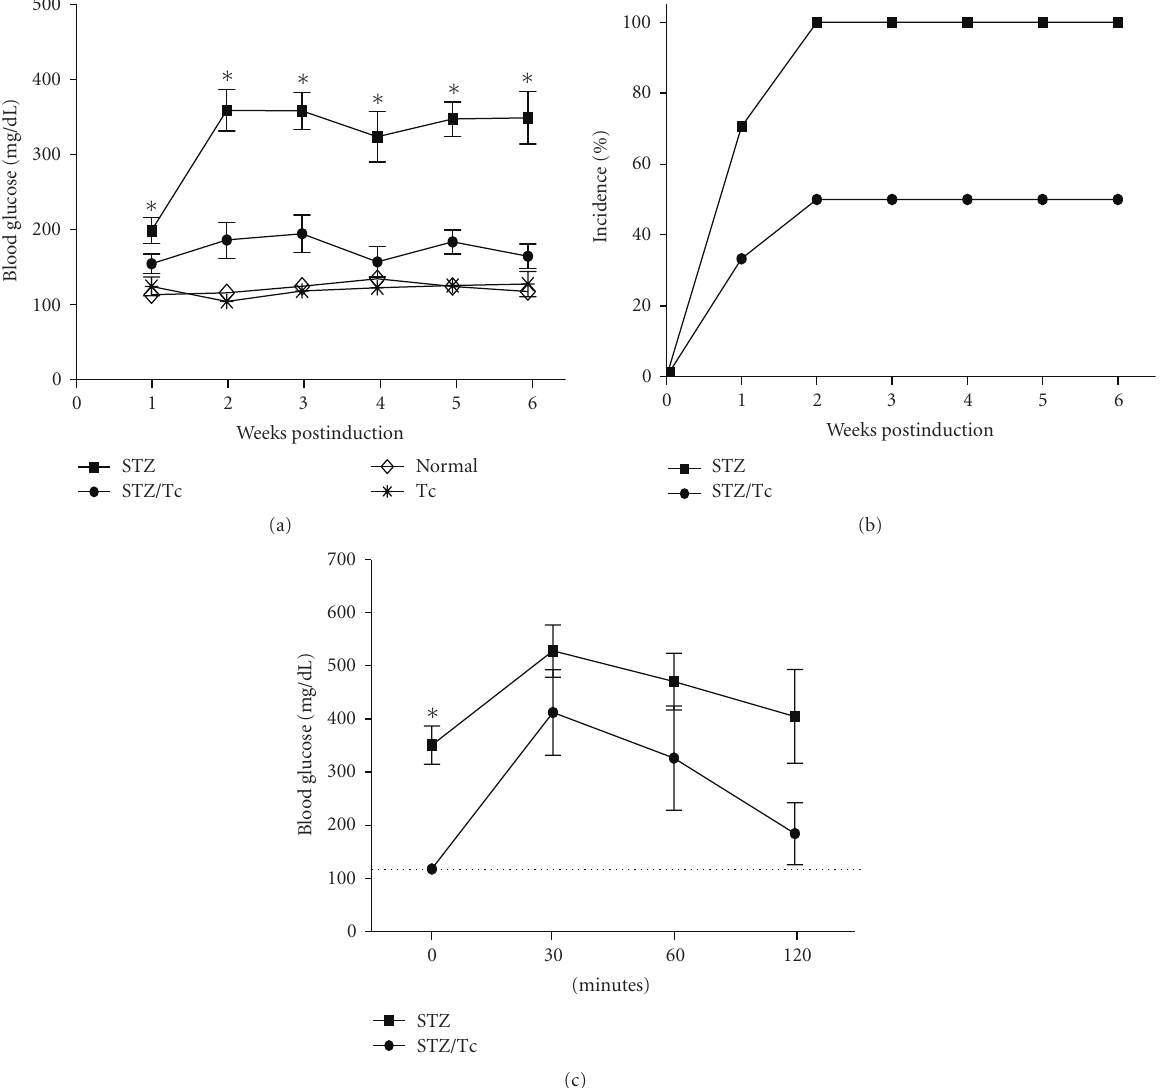
Figure 1: Hyperglycemia and diabetes incidence is modified by T. crassiceps infection in BALB/c mice. (a) Blood glucose levels throughout the MLDS protocol for uninfected BALB/c mice and BALB/c mice infected with T. crassiceps for 6 weeks. (b) Percent incidence of diabetes between uninfected and T. crassiceps -infected BALB/c mice. (c) Intraperitoneal glucose tolerance test for MLDS-treated uninfected and T. crassiceps- infected mice. Dotted line indicates normal glucose values. ∗ P < . 05, n = 12.